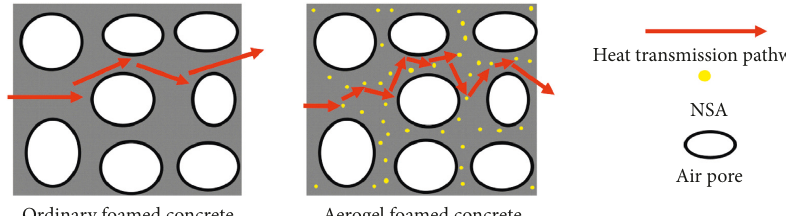
Figure 8: The heat transmission